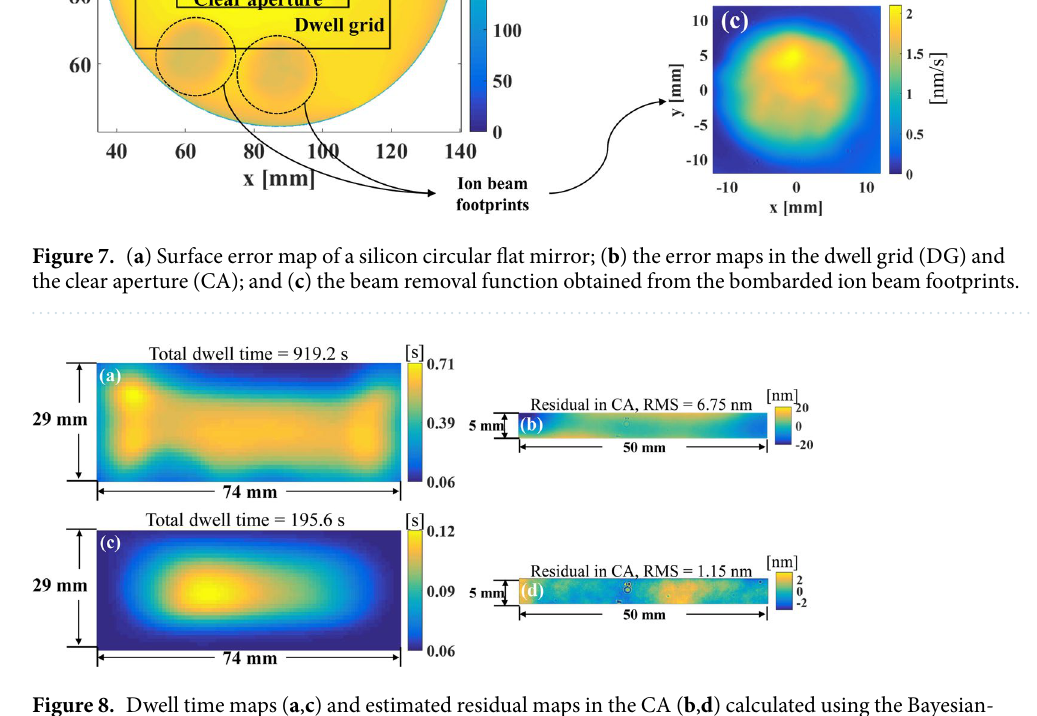
Figure 8. Dwell time maps ( a , c ) and estimated residual maps in the CA ( b , d ) calculated using the Bayesian- based algorithm ( a , b ) and the TSVD algorithm ( c , d ).